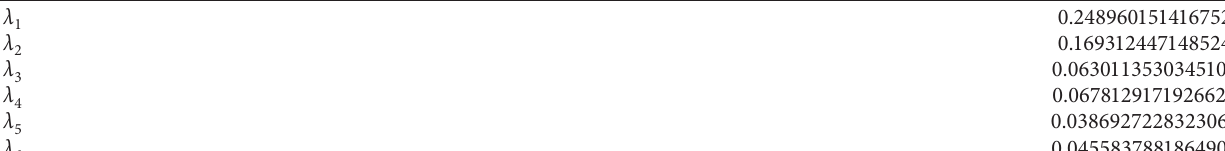
Table 9: The parameters of the DBGM (1, N ) model in case 4.